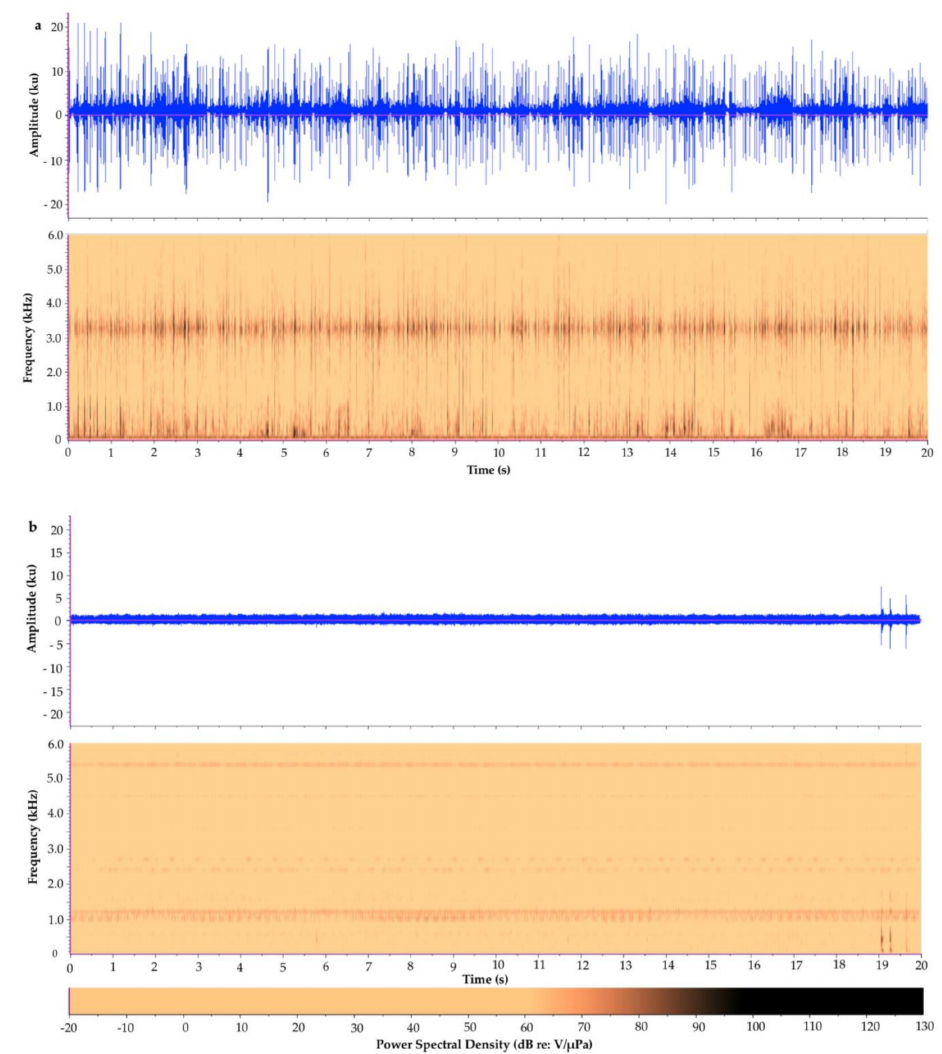
Figure 2. Waveform and spectrogram of ( a ) a 20-s recording from Tunicate Cove, Belize, 1996 and ( b ) a 20-s recording from Glovers Atoll, Belize, 1999. Note: the dark band at around 1.1 kHz–1.2 kHz is from camera noise, which is evident in this overall very quiet recording. The bottom row is the color bar representing the power spectral density (in dB) values in the